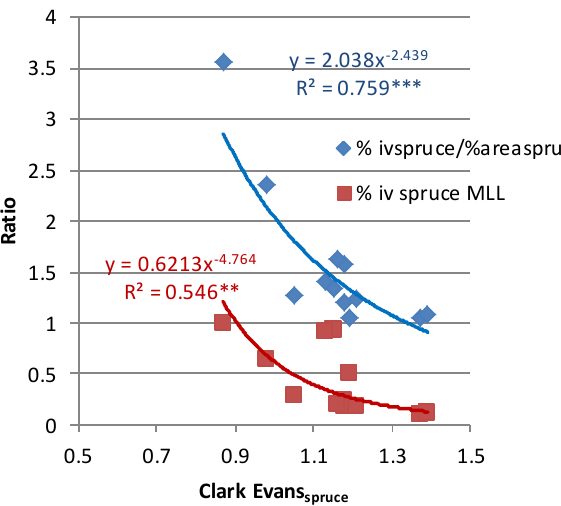
Figure 11. The ratios “growth of spruce by total growth divided by its proportion by area” (%iv spruce/%area spruce) and “growth of spruce in the middle and lower layer (MLL) by total growth of spruce” (%iv spruce MLL), depending on the spatial distribution (Clark Evans index) of spruce. * p ≤ 0.05; ** p ≤ 0.01; *** p ≤ 0.001.